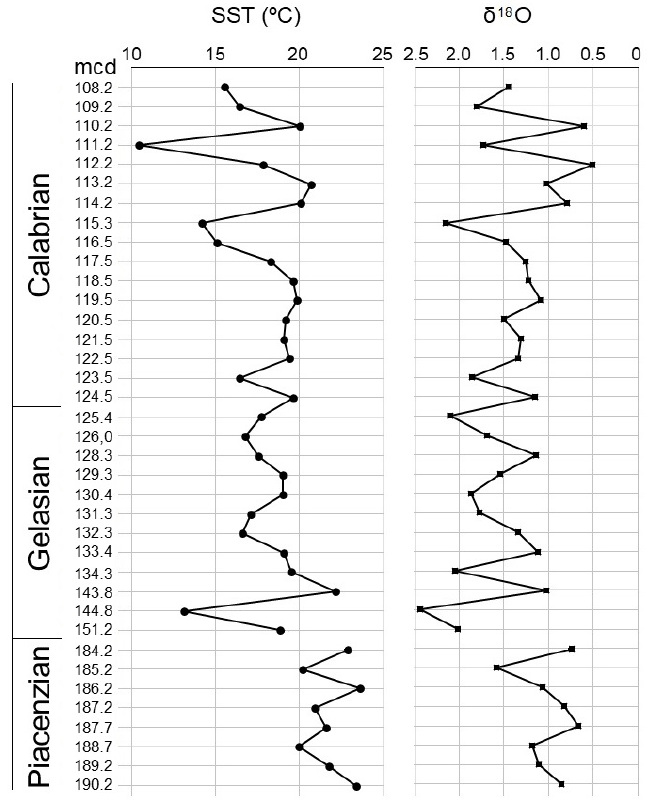
Figure 5. SST estimates and δ 18 O values for Upper Pliocene–Lower Pleistocene samples from the ODP-site 975.